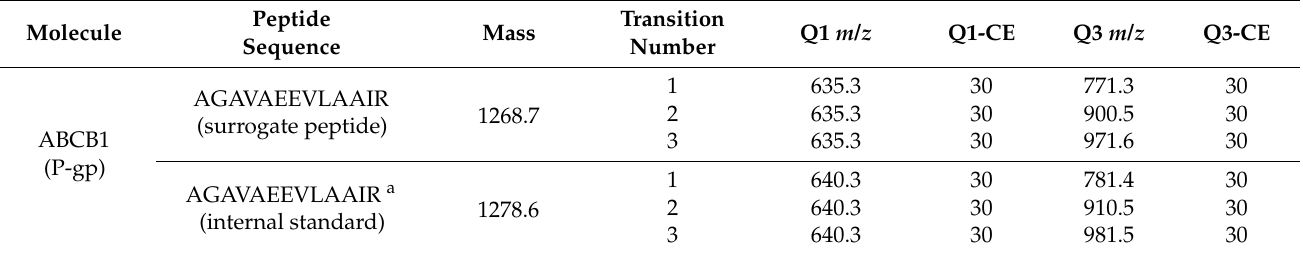
Table 1. Tryptic proteospecific peptide and its respective ions and mass transitions used for P- glycoprotein (P-gp)